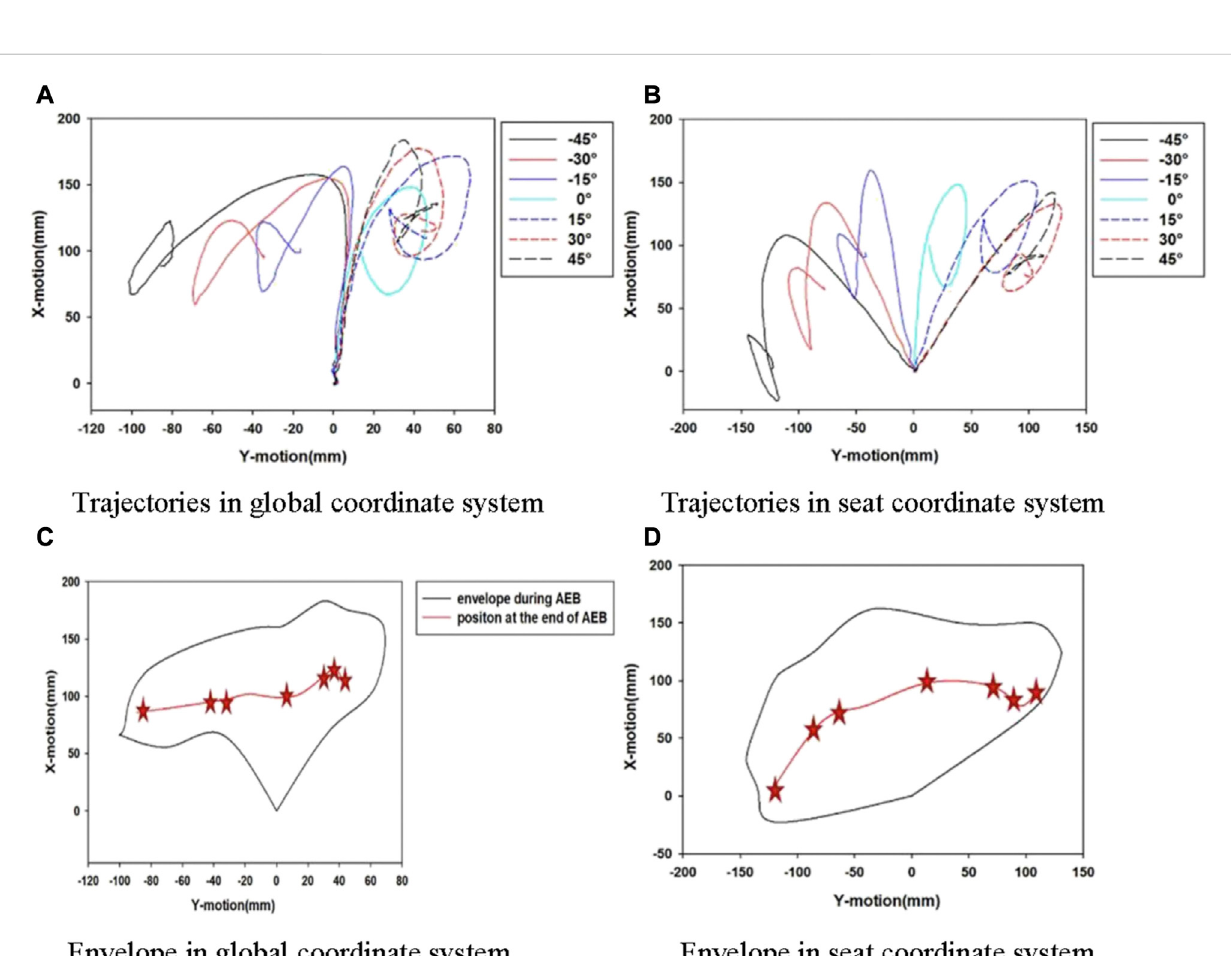
FIGURE 12 Head CG trajectories and envelope for all seating arrangement. (A) Trajectories in global coordinate system (B) Trajectories in seat coordinate system (C) Envelope in global coordinate system (D) Envelope in seat coordinate system.